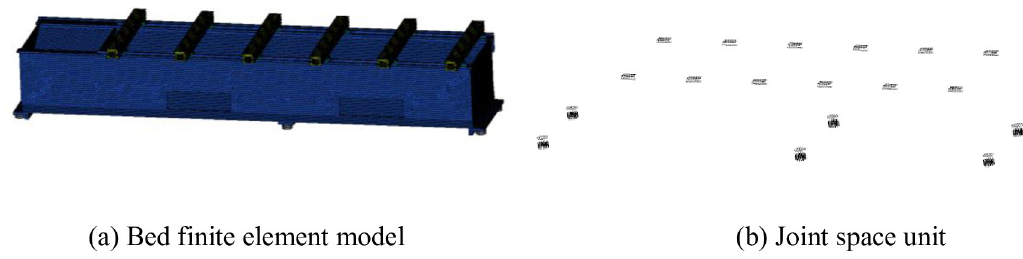
Fig 5. Bed structure finite element model and joint space unit. (a) Bed finite element model, (b) Joint space